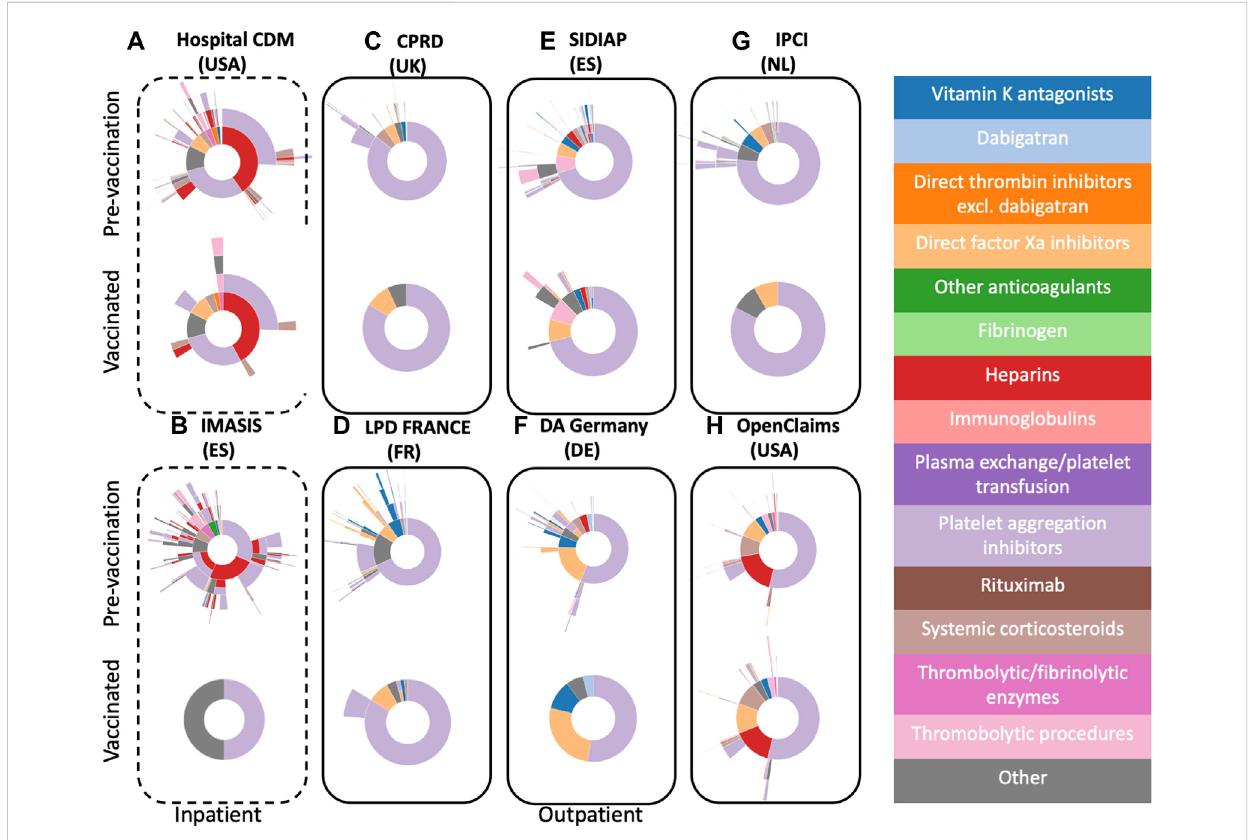
FIGURE 3 Sunburst plots visualizing treatment pathways for ATE patients in pre-vaccination cohorts (top) versus vaccinated cohorts (bottom). Inpatient databases are depicted with a dashed line frame, whilst outpatient ones have a solid